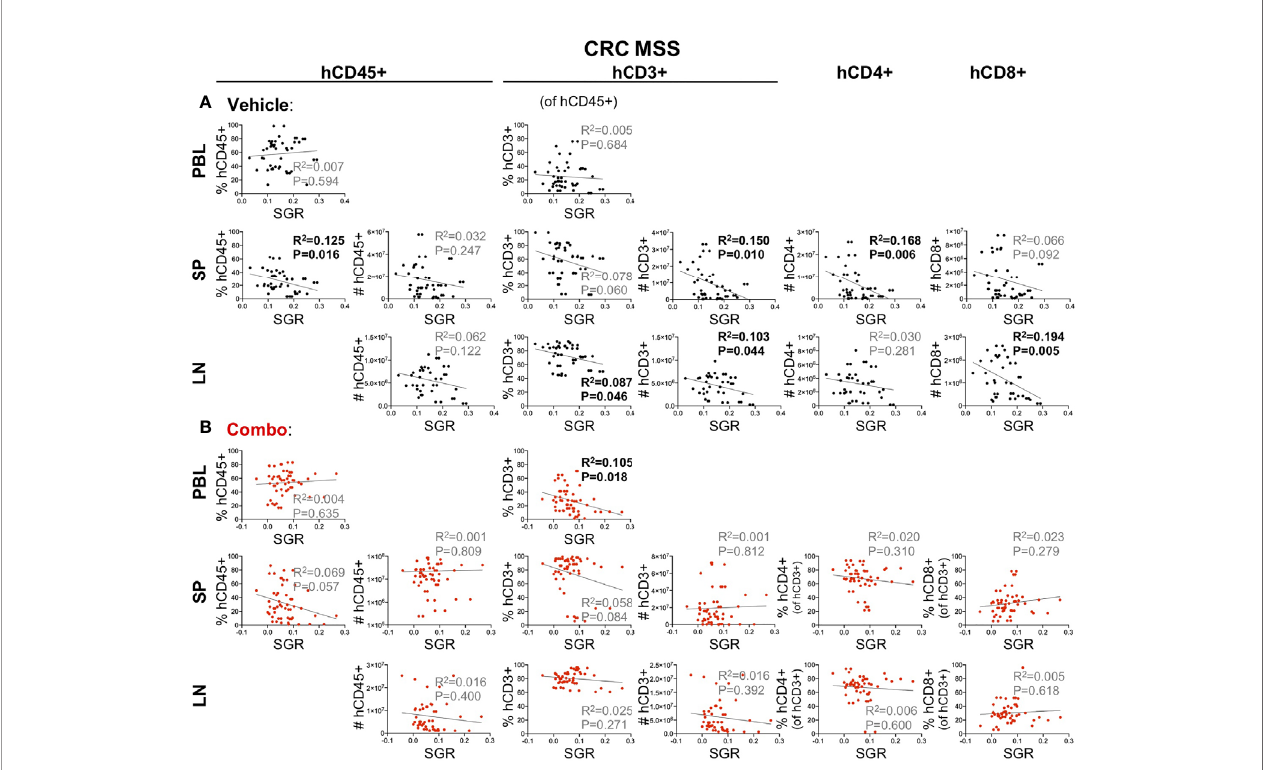
FIGURE 6 | Correlation of tumor growth and human chimerism in lymph organs for 5 CRC MSS PDX models (B2, D2, D3, E, F) in HIS-BRGS mice receiving either no treatment (A) or a combination immunotherapy (B) . Linear regression analysis was performed between tumor speci fi c growth rate (SGR) and immune cell populations in the blood prior to tumor injection (PBL at 15 weeks) or in the spleen (SP) and lymph nodes (LN) at end of study. [Linear regression analysis, R-squared score (R 2 ) and P value (P) in bold if statistically signi fi cant (P <